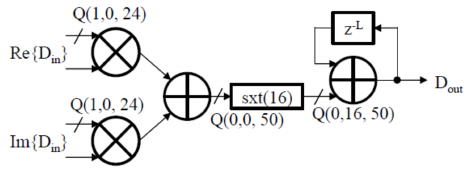
Figure 14. Number format for magnitude evaluation and accumulation.